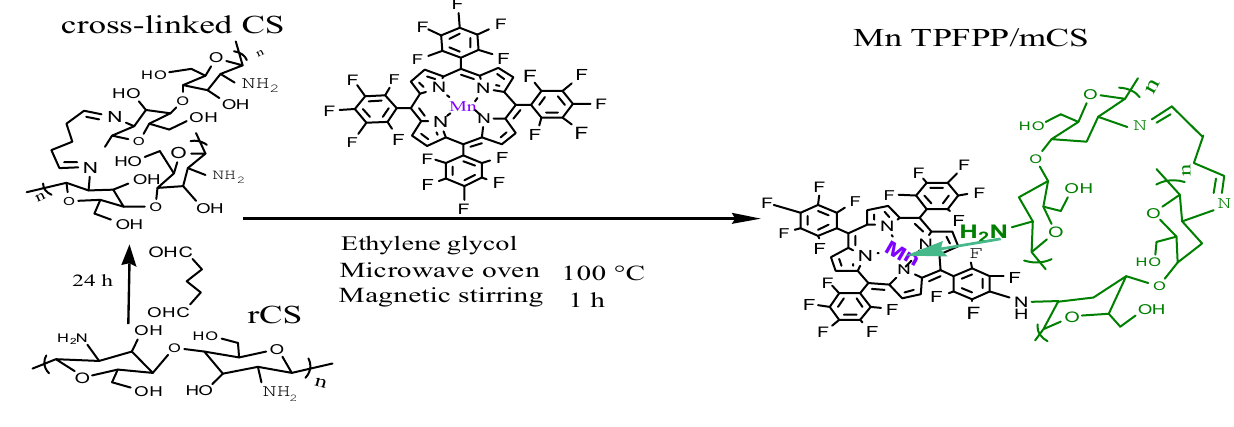
Scheme 1. Preparation route for Mn